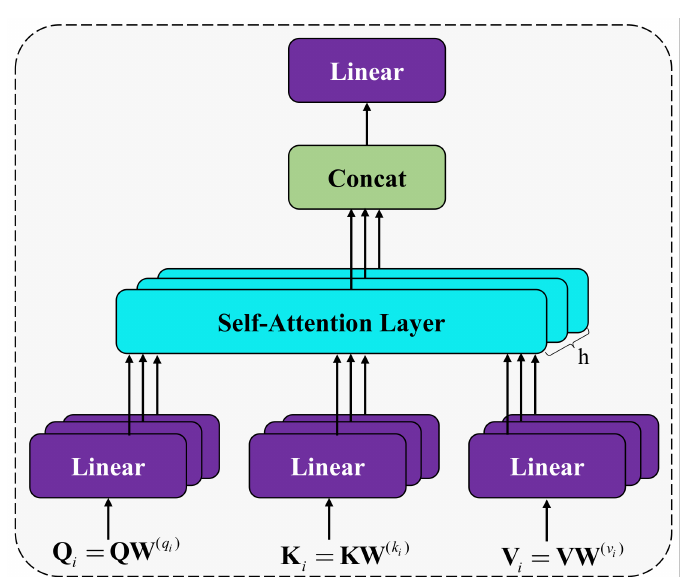
Figure 4. The architecture of the self-attention aggregation module.